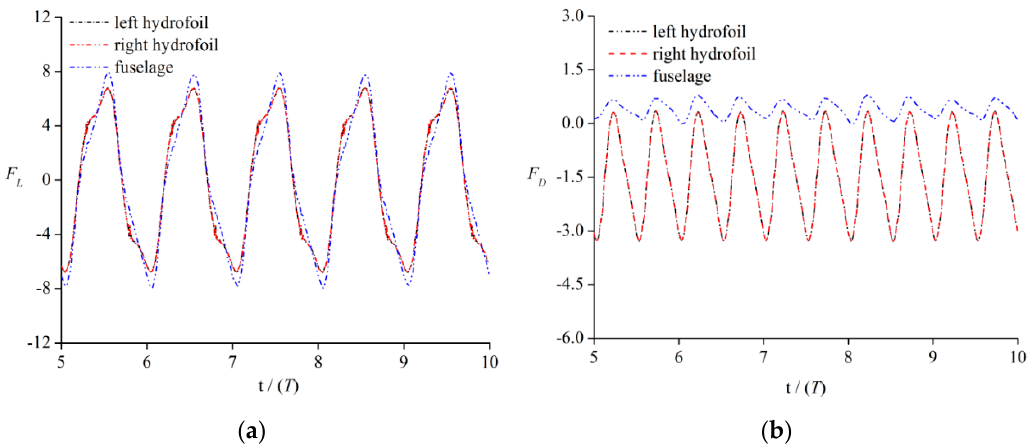
Figure 3. Lift and drag force histories of twin wings and fuselage. ( a ) Lift force; and ( b ) drag force. Table 1. Mean values of the lift and drag forces of twin wings and fuselage.